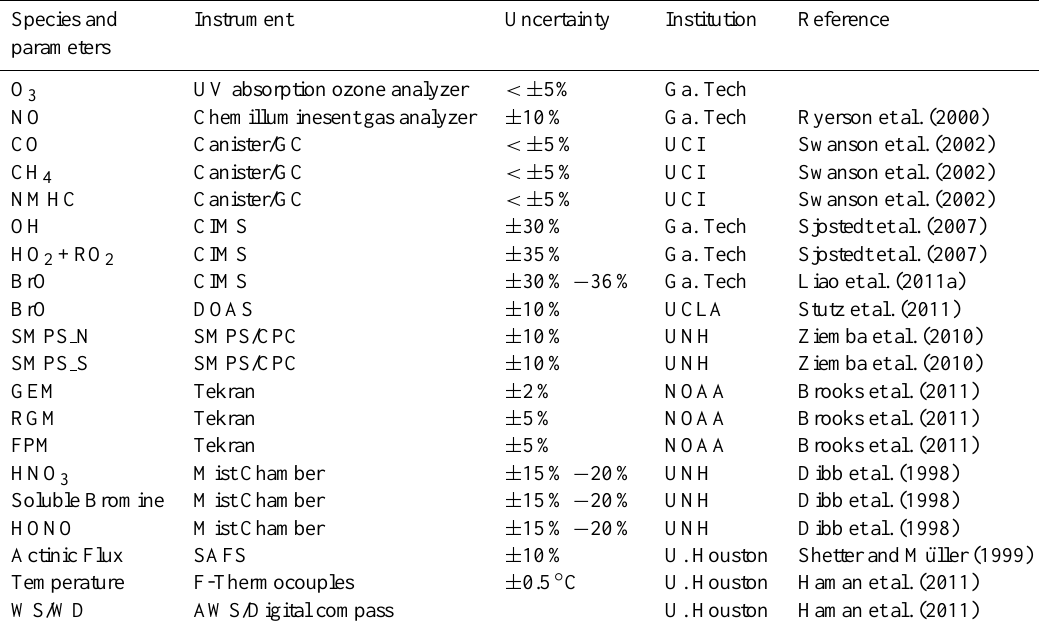
Table 1. Summary of the measurements at Summit, Greenland 2007–2008. Species